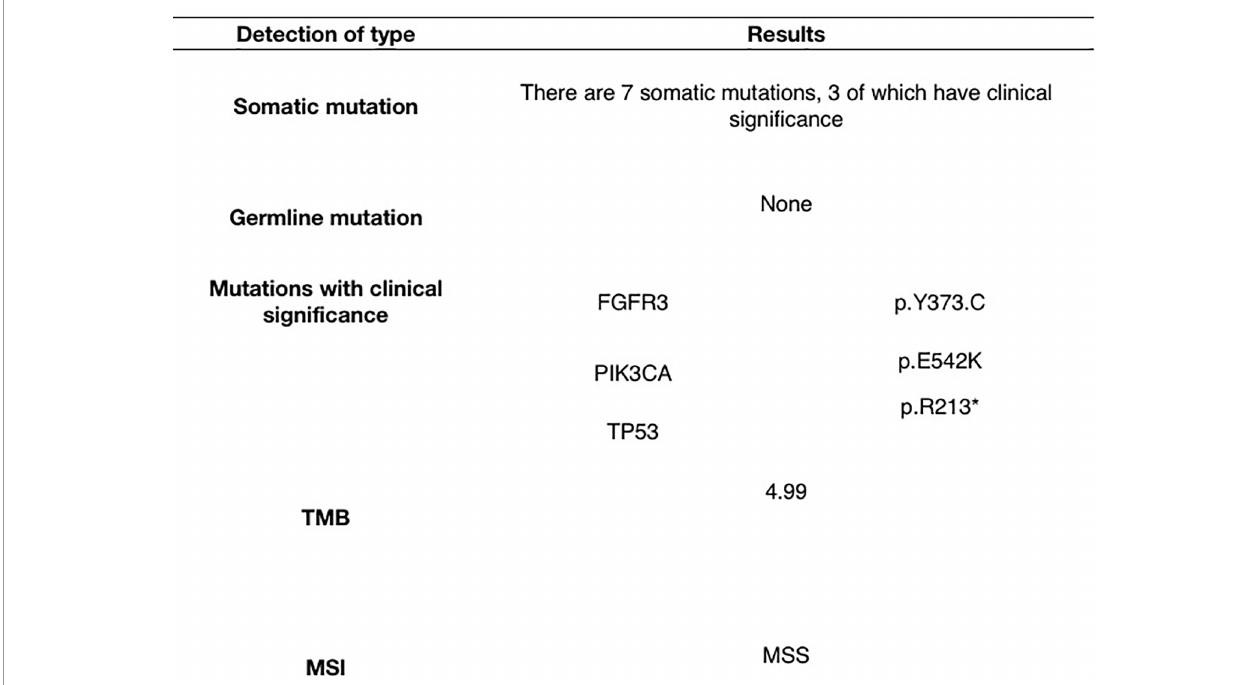
FIGURE 3 | The molecular characterization.